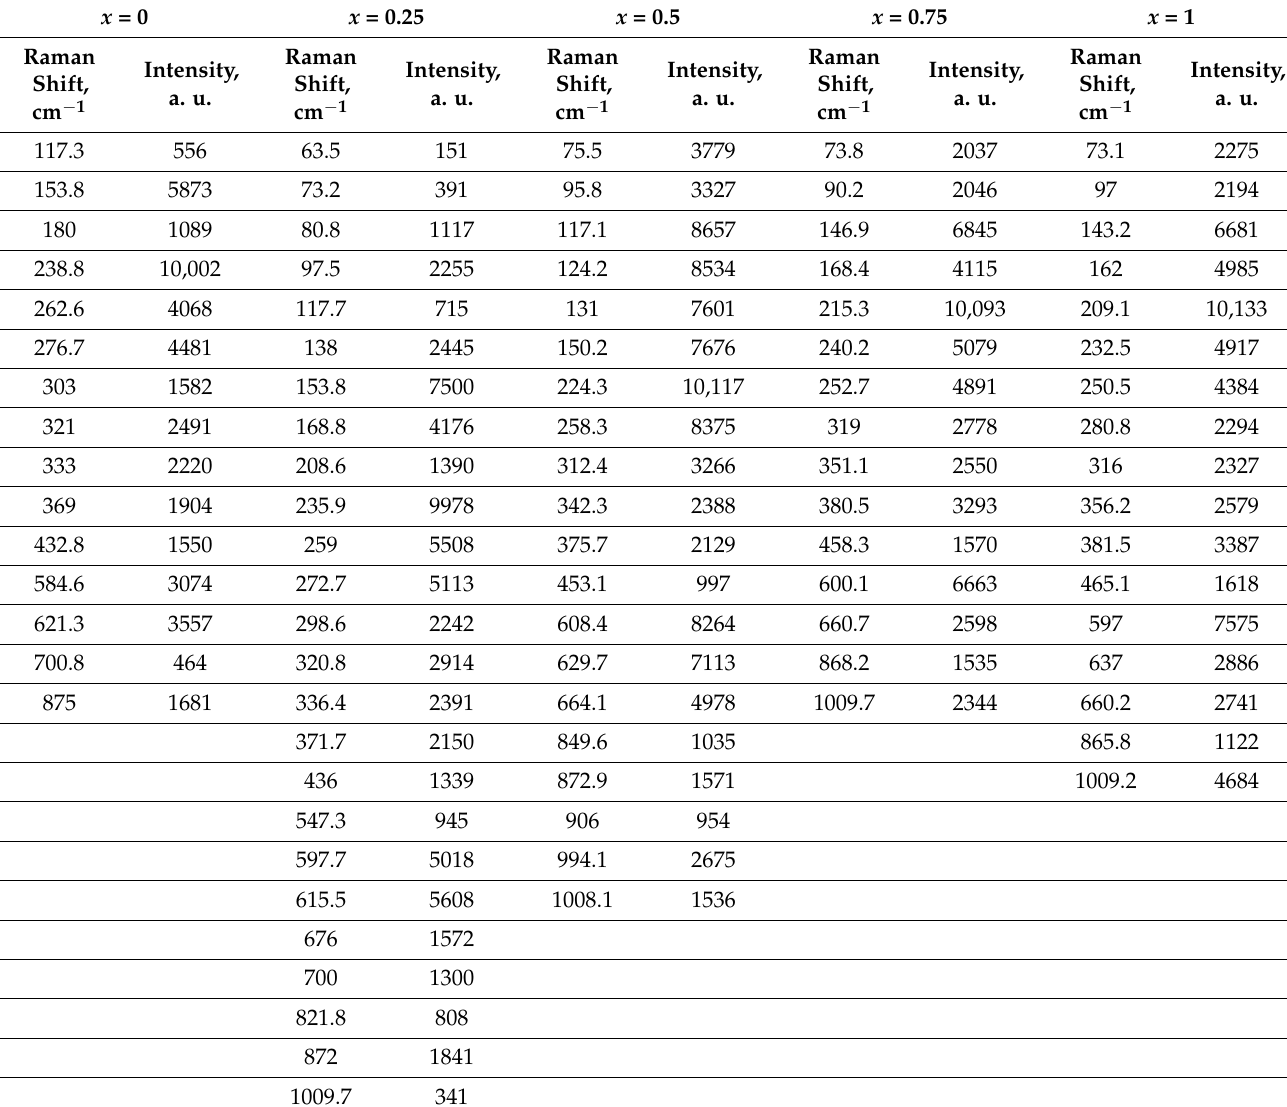
Table 3. The observed bands in Raman spectra of LiNb 1 − x Ta x O 3